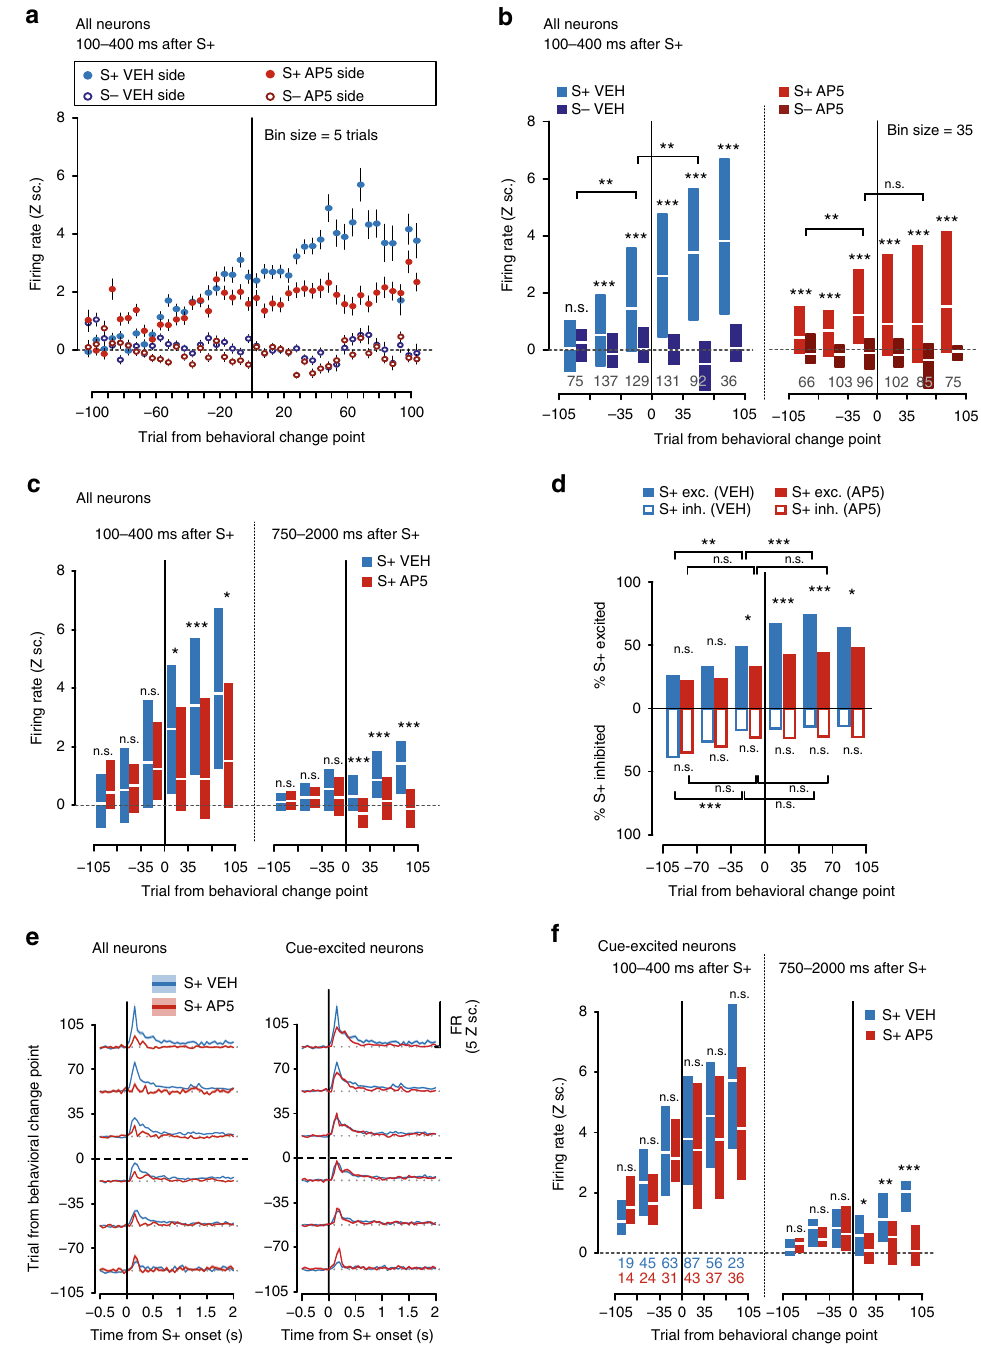
Fig. 7 AP5 prevented large and prolonged NAc cued excitations from emerging with training. a Mean ± SEM excitation 100 – 400 ms after S + (solid) or S − (empty) in the saline (VEH, blue) or AP5 (red) hemispheres in fi ve-trial bins around CP. Z sc.: Z scores. b Same as in a , but median and interquartile range are shown in 35-trial bins. Activity was higher after S + than S − onset at least 70 trials before CP in both hemispheres (*** p < 0.001, Wilcoxon). After CP, S + -evoked activity increased in the vehicle (** p < 0.01), but not the AP5-treated side ( p > 0.05, Wilcoxon). Numbers indicate sample size. c Comparison of post-S + activity across hemispheres. After CP, population activity was higher in the vehicle than in the AP5-treated side in the 100 – 400 and 750 – 2000ms post-S + windows (* p < 0.05; *** p < 0.001, Wilcoxon). d Proportion of excited (top) or inhibited (bottom) units after S + onset around the CP. The proportion of S + -excited units was higher in the vehicle (blue) than in the AP5 side (red) right before CP and remained higher thereafter (* p < 0.05; *** p < 0.001, Fisher). e Mean ± SEM activity around the S + of all (left) or cue-excited (right) units in the vehicle (blue) or AP5 (red) sides. f Same as in c , but for cue-excited neurons (* p < 0.05; ** p < 0.01; *** p < 0.001, Wilcoxon); n.s. not